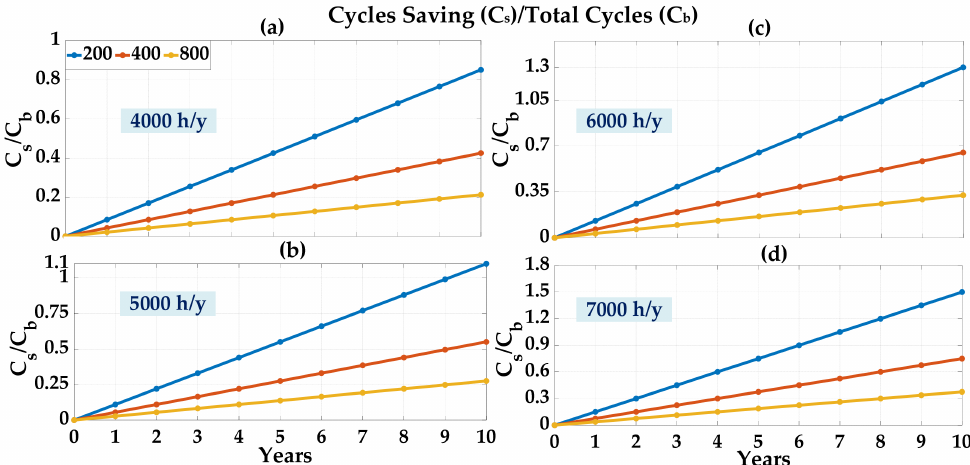
Figure 11. Number of the cycles that are saved (C s ) as a portion of the total battery operating cycles (C b ), for the ten-year period of the analysis; ( a ) 4000 h/y, ( b ) 5000 h/y, ( c ) 6000 h/y, ( d ) 7000